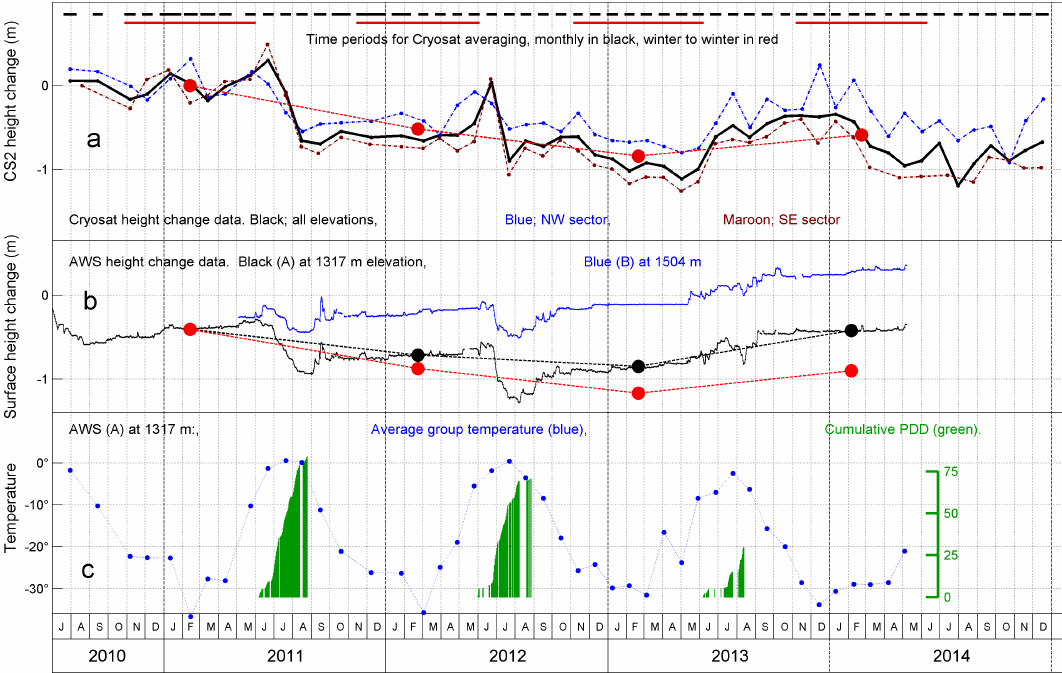
Figure 7. (a) Average CS2 height change over Devon Ice Cap as a function of time from July 2010 until December 2014 for all elevations (black), and for the NW (blue) and SE (maroon) sectors shown in Fig. 6. The short dashed black lines at the top indicate the time periods encompassing the CS2 passes which have been combined for the high temporal resolution plots. The four red dots indicate the winter-to- winter height change for all the elevation data for the time periods shown by the horizontal red lines. (b) Surface height change recorded by an ultrasonic surface height sensor on the AWS labelled A in Fig. 6. Black dots indicate the height change averaged over the same time frames as the CS2 winter-to-winter height change. The red dots show the same data corrected for the AWS vertical displacement. (c) Average AWS temperature data at the CS2 pass times (blue dots) and the cumulative positive degree day data